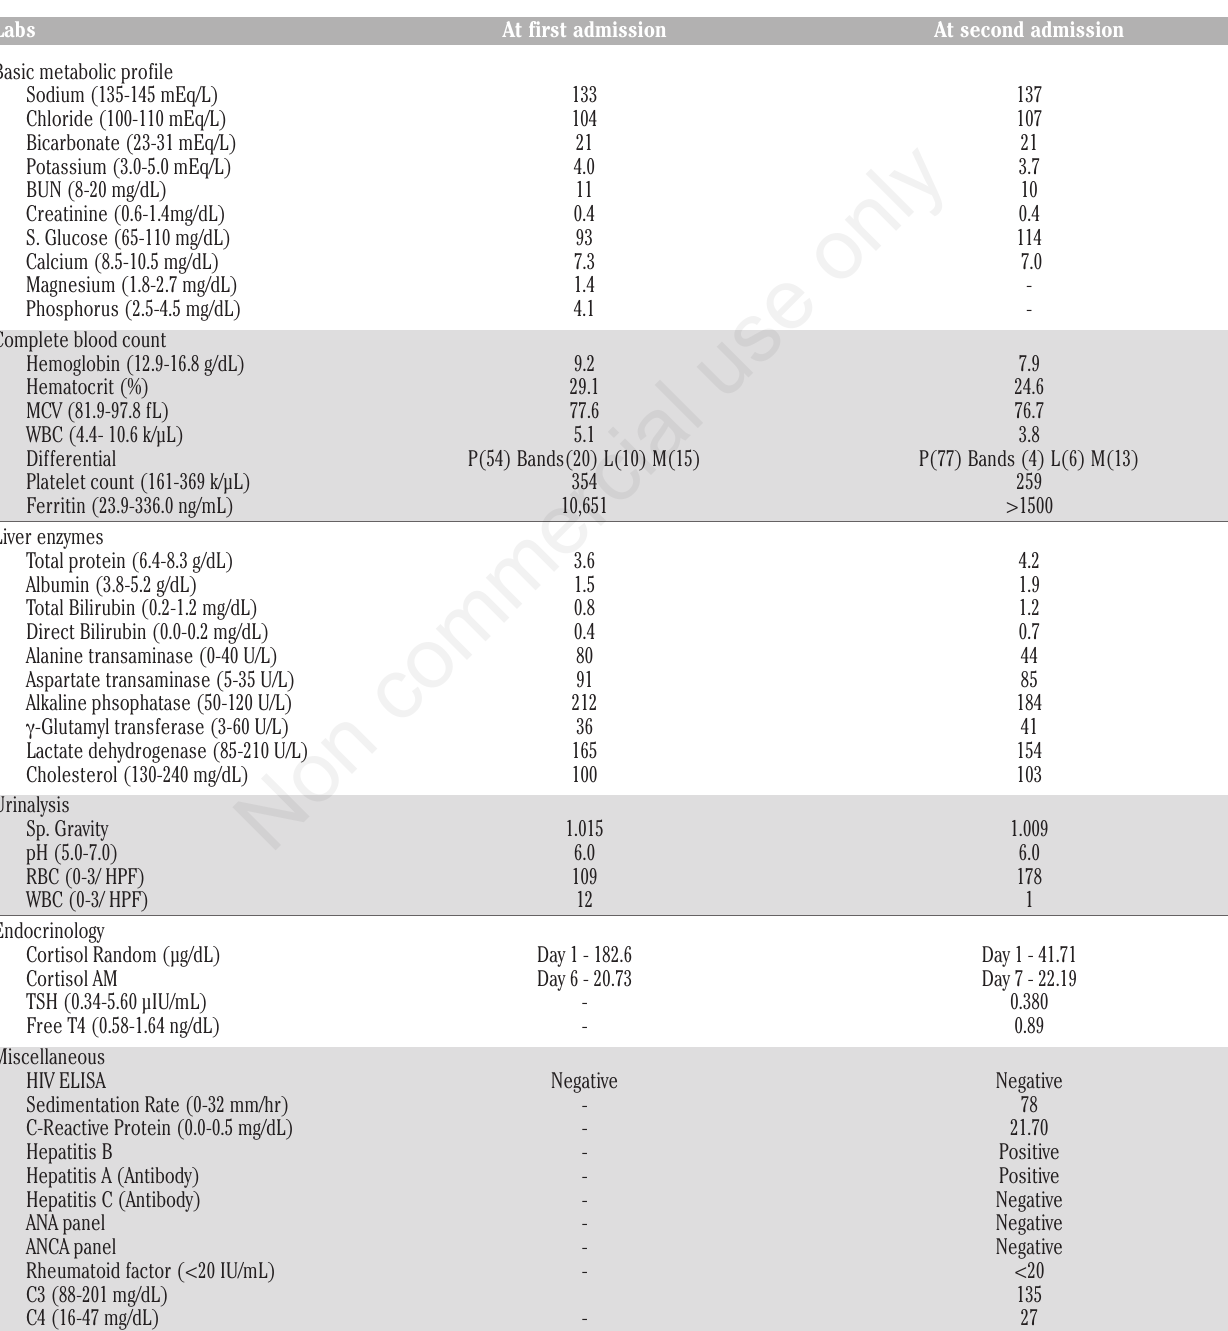
Table 1. Labs at first and second admission.